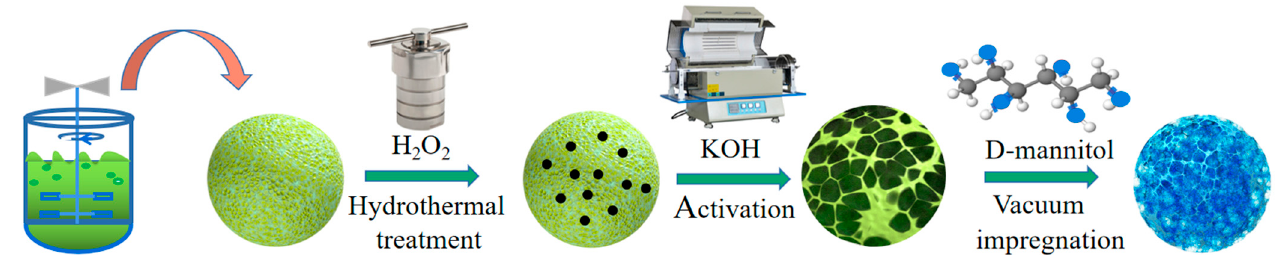
Figure 1. Diagram for the preparation of YC/D-mannitol ss-PCM.